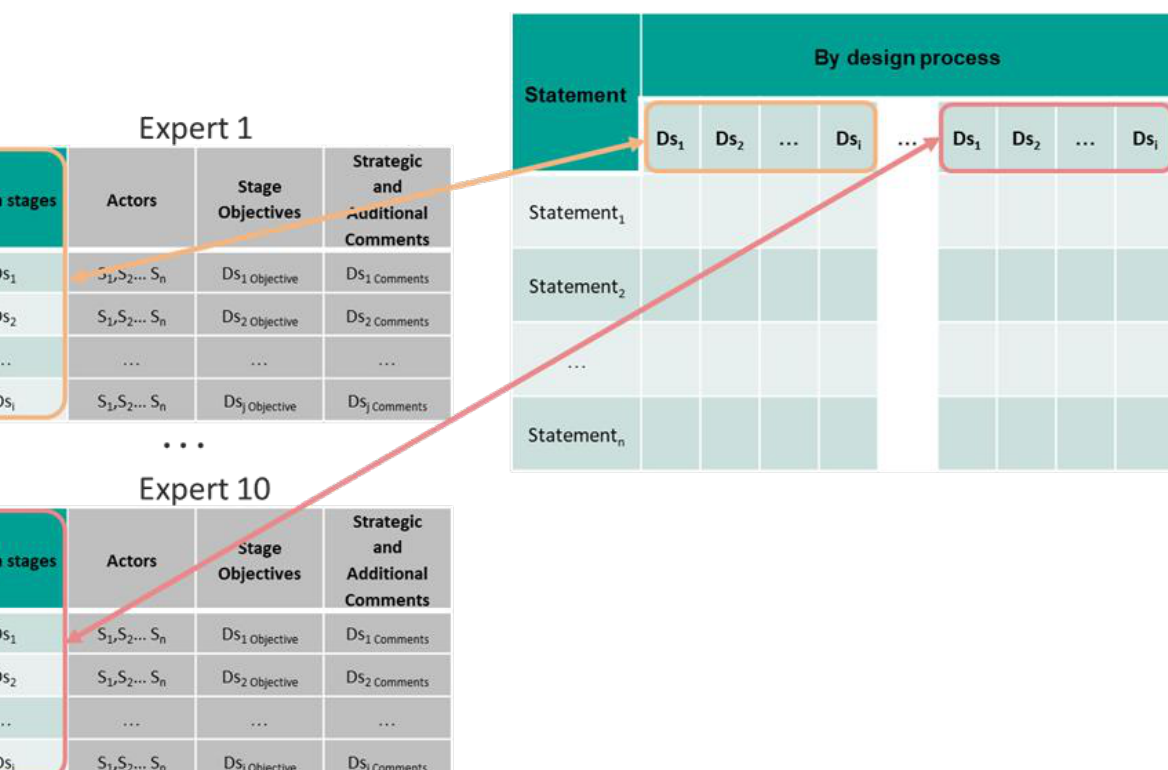
Figure 5. Data collection regarding involved actors.